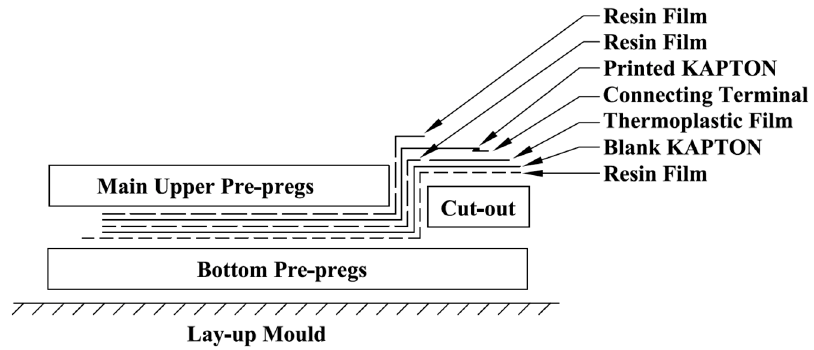
Figure 2. Schematic of embedding procedure during lay-up.